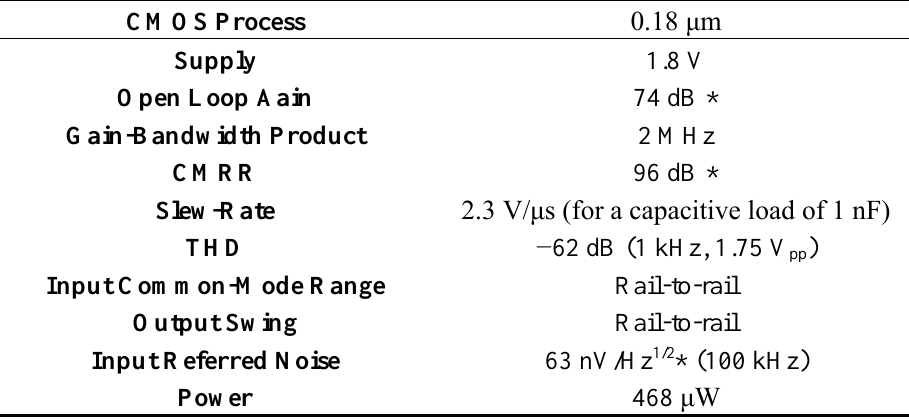
Figure 4. Schematic of the designed 1.8 V class AB rail-to-rail two stage OpAmp. The auxiliary control circuit for rail-to-rail operation is depicted in grey. Table 2. Operational amplifier performance